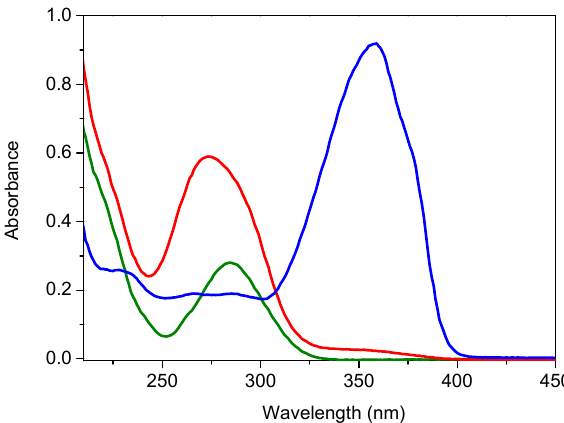
Figure 1. UV-Vis absorption spectra of avobenzone (AB, blue), diclofenac (DCF, green), and the dyad AB-DCF (red) in ethanol at ca. 1.5 × 10 − 5 M.